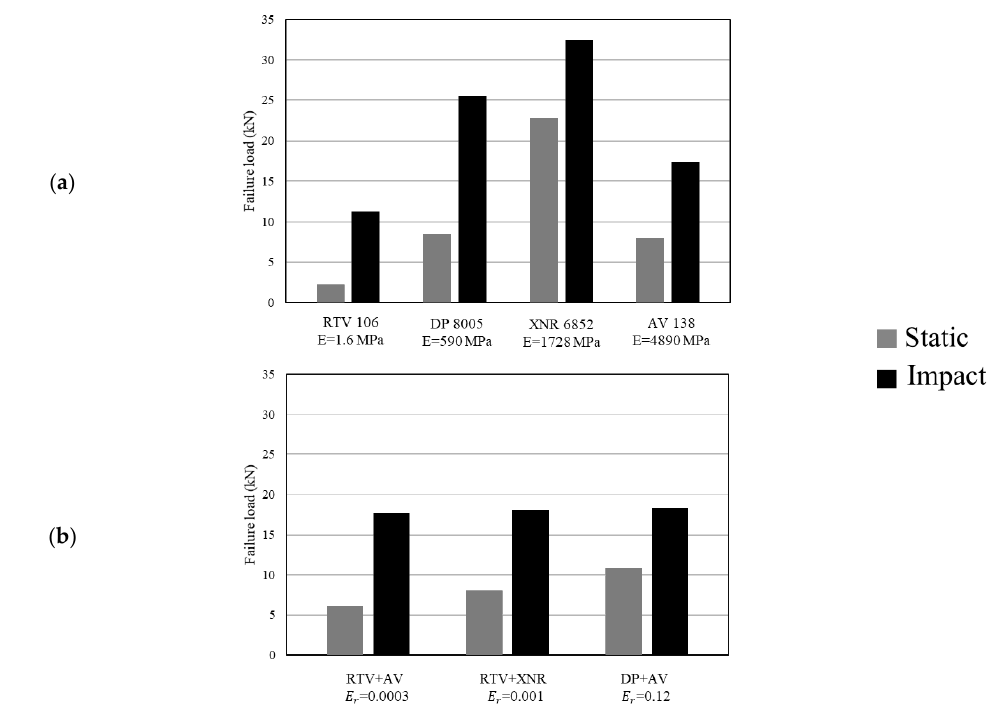
Figure 9. Failure load for single and mixed adhesive joint for ( a ) single adhesive (E represents the adhesive ’s Young ’ s modulus) and ( b ) mixed adhesive joint (E r represents the ratio of flexible adhe-